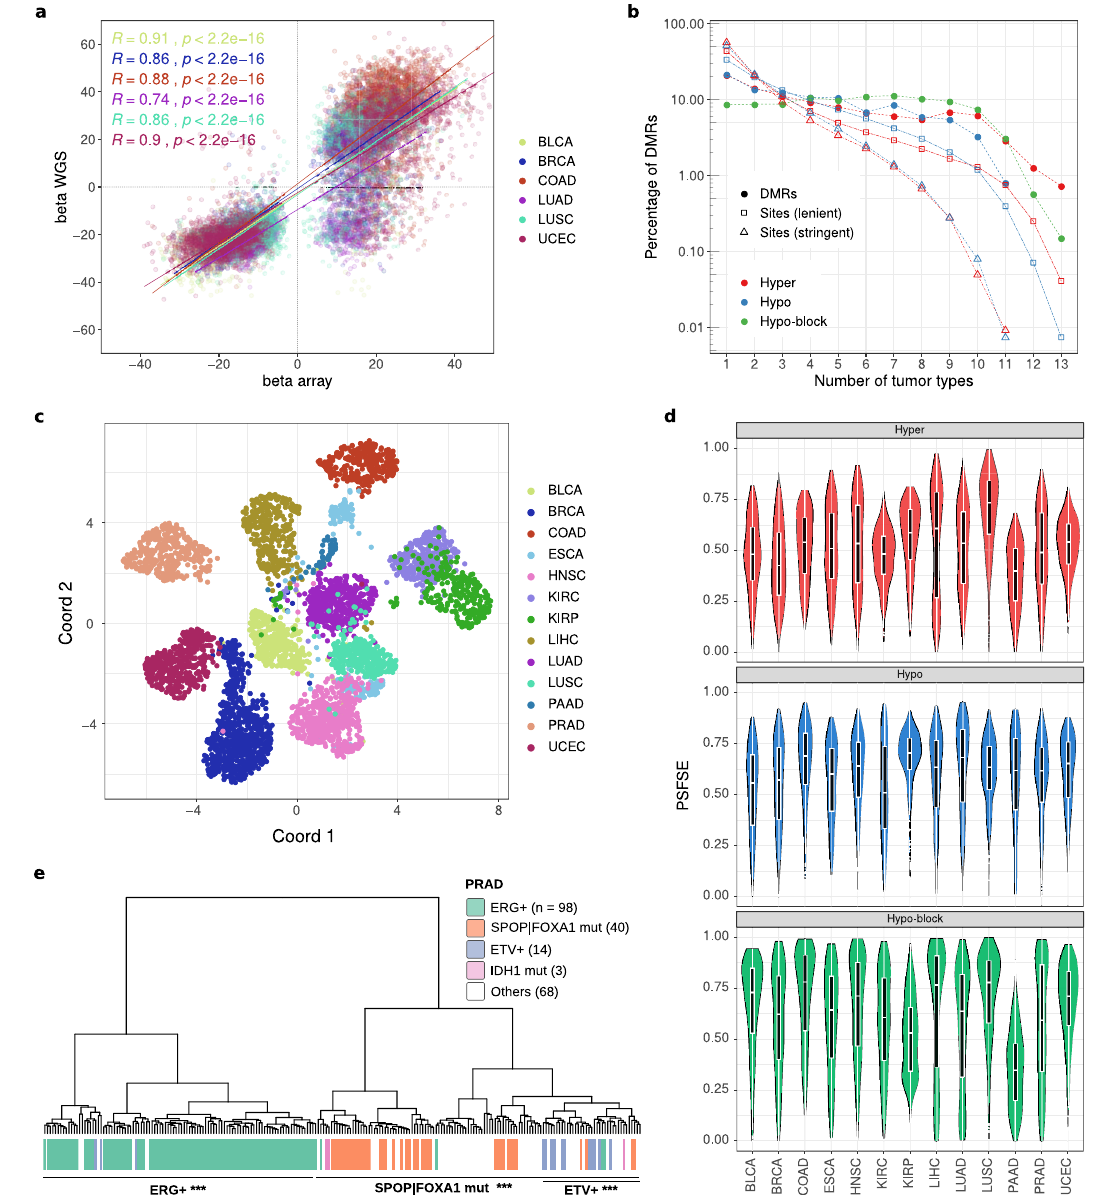
Fig. 3 A Catalog of DMRs across multiple tumor types. a Correlation between average beta difference in DMRs detected from WGBS data ( y axis) and HM450 data ( x axis). Pearson ’ s correlation coef fi cients ( R ) and corresponding p -values are reported. b Fraction of shared differential methylation events across tumor types. Solid line: DMRs, dashed line: single CpG sites. Hypo DMSs and Hyper DMSs were selected using AUC below 0.2 and above 0.8 (lenient) or below 0.1 and above 0.9 (stringent). c Uniform manifold approximation (UMAP) of TCGA samples based on the average beta difference in each DMRs of the consensus set with respect to matched normal tissue. d Distribution of the per sample fraction of supporting events (PSFSE) for each class of DMRs (hyper: top, hypo: middle, hypo-block: bottom) across tumor types. e Unsupervised hierarchical clustering of TCGA-PRAD dataset based on DMRs z -scores. Molecular subtypes of tumor samples are